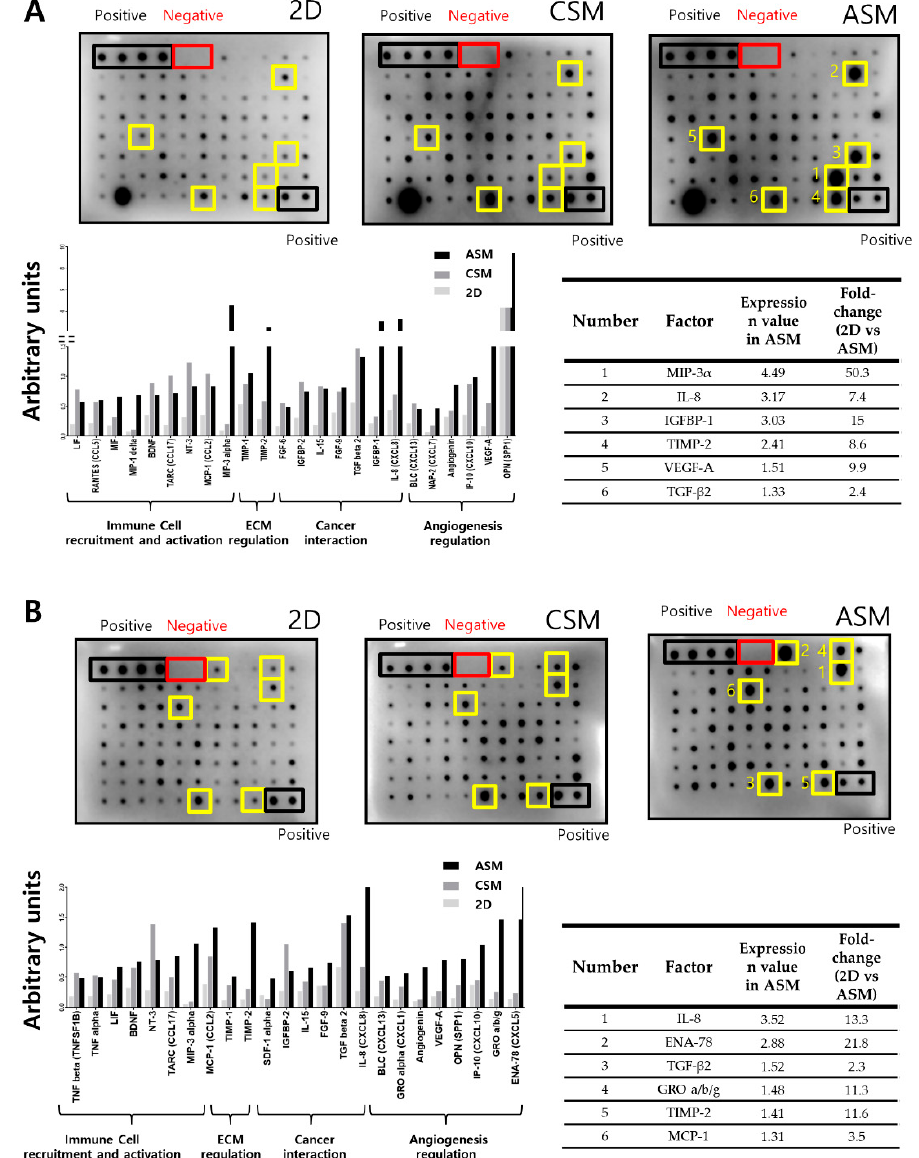
Figure 5. Cell proliferation and drug resistance-related cytokine secretion analysis. Increased secretion of chemokines and cytokines in conditioned media (CM) of ASM culture condition. Representative images of human cytokine array analysis in CM of HepG2 ( A ) and Hep3B ( B ). The graph indicates factors showing increases to the top 30% in the ASM. Six factors were detected to be the highest under ASM culture conditions (yellow boxes).